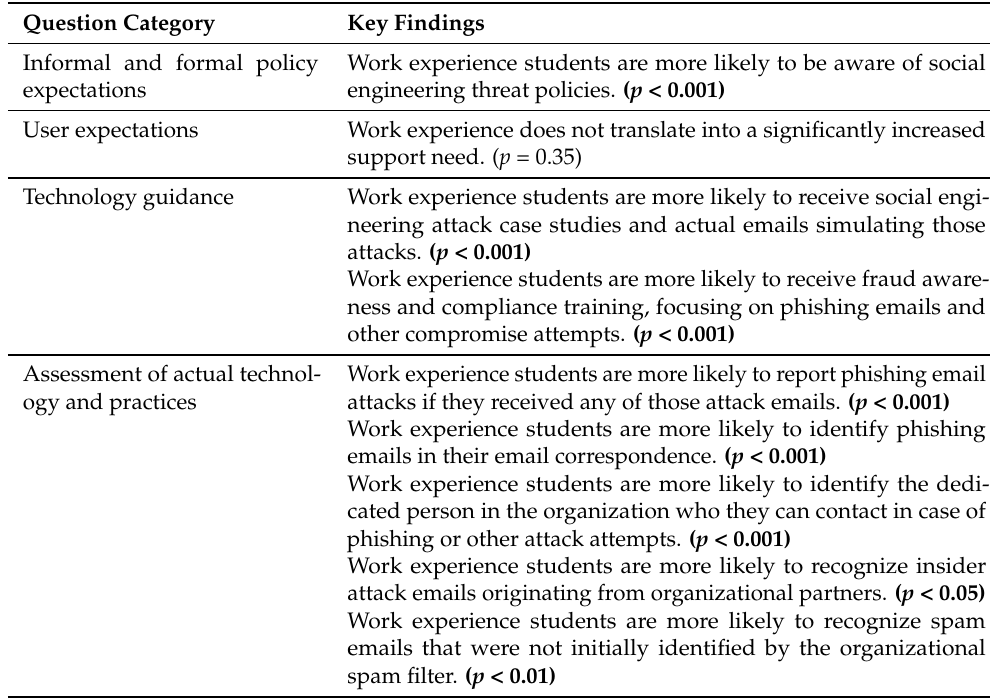
Table 8. Summary of key findings: social engineering